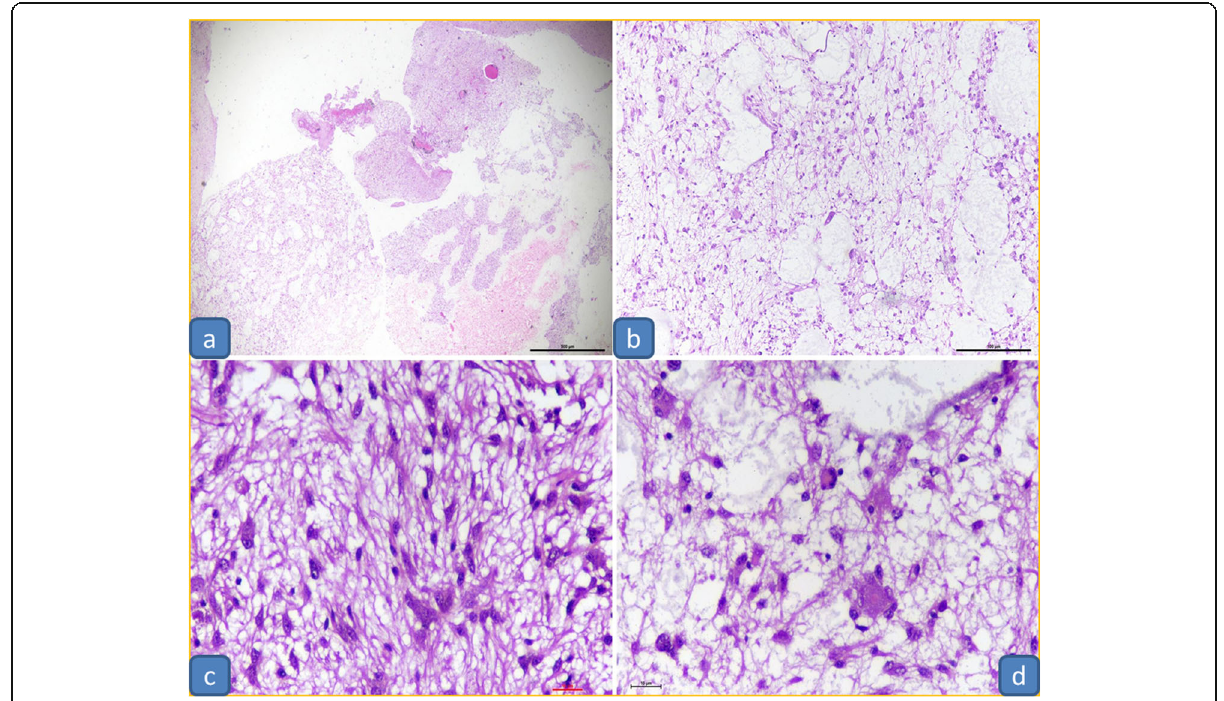
Fig. 3 a A glial tumor arranged in fascicles and diffuse sheet (H&E × 20, × 100). b, c The tumor cells are round to oval, which show moderate nuclear pleomorphism, hyperchromatic nuclei, and vacuolated to eosinophilic cytoplasm in few of them (arrow) (H&E; X400). d Few bizarre cells and giant cells are also seen (H&E ×